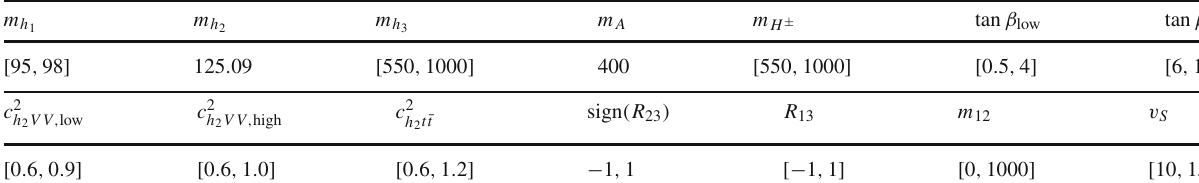
Table 2 Values of input parameters for the scans in the low and high tan β regime